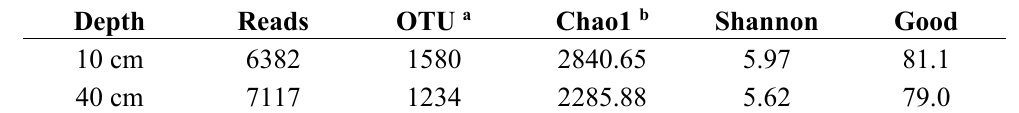
Table 3. Comparison of diversity estimation of 16S rRNA sequencing from mangrove samples. Depth